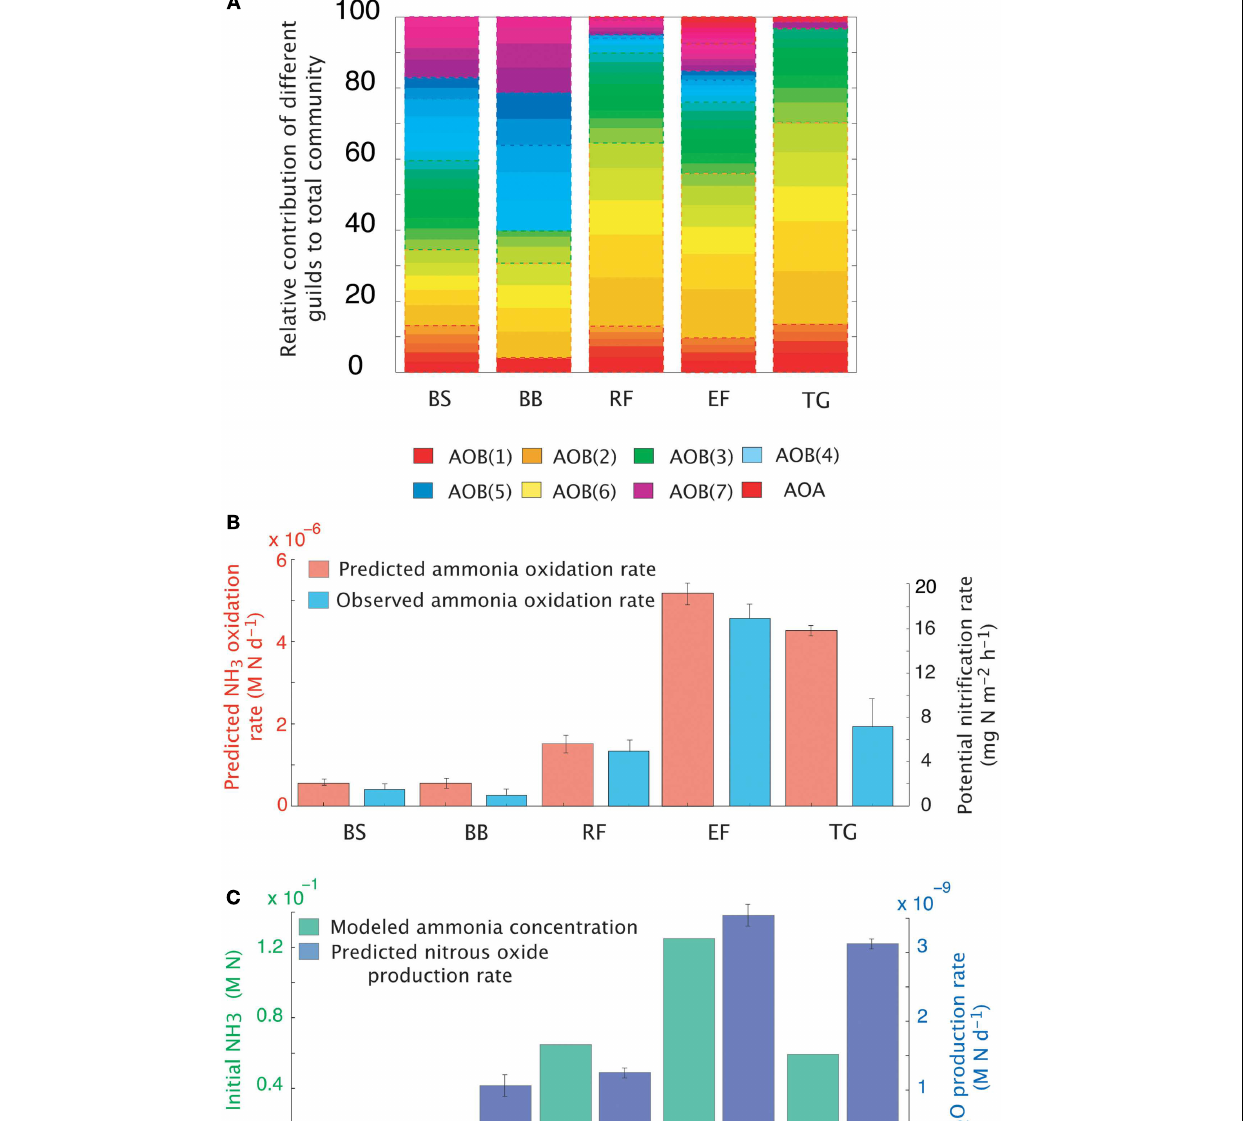
FIGURE 6 | Simulations of the activity and diversity ofAOB communities in high-latitude ecosystems. (A) Monte Carlo simulations of multiple AOB analogs ( n = 5 analogs per guild) across the different sites. Each guild is represented by a distinct color. Subtle differences in the shade of that color demarcate the different analogs/guild. A box outlines the boundaries of each